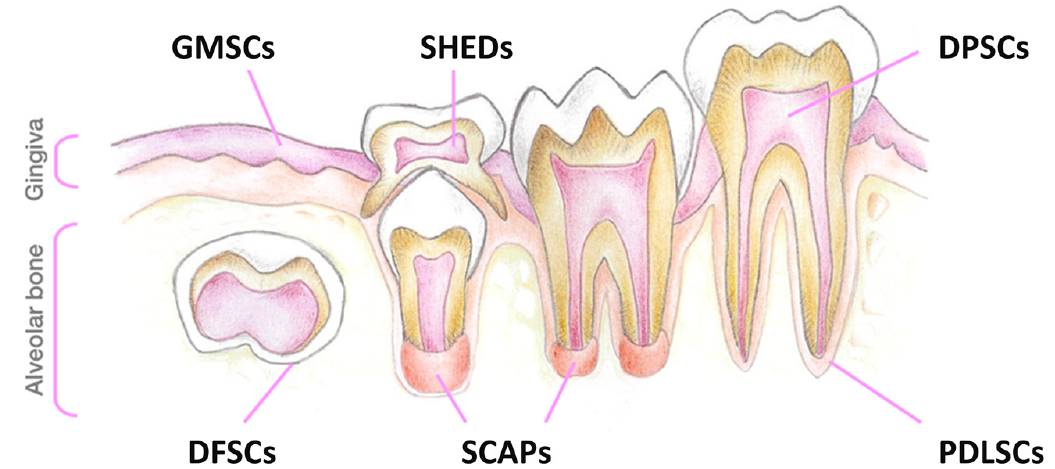
Figure 5. Schematic drawing illustrating the sources of dental mesenchymal stem cells (DMSCs) in the oral cavity. Abbreviations: GMSCs, gingiva-derived MSCs; DFPCs, dental follicle progenitor cells; SHED, stem cells from exfoliated deciduous teeth; SCAPs, stem cells from the apical papilla; DPSCs, dental pulp stem cells; PDLSCs, periodontal ligament stem cells.